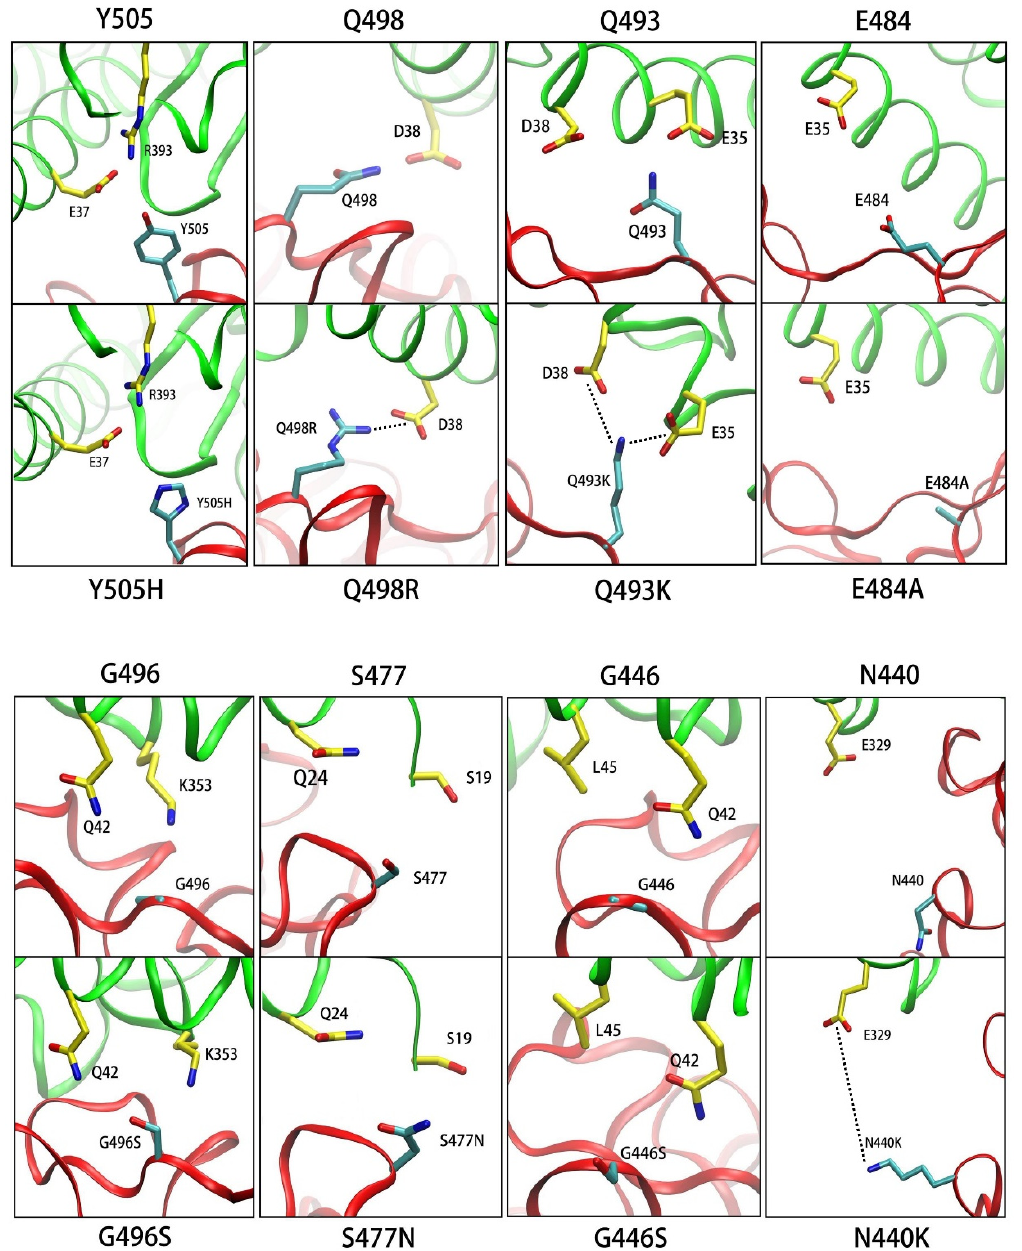
Figure 6. The local interaction structures of the wild type (above figures) and mutants (below figures) in SARS-CoV-2 S-protein/ACE2 complexes. The wild-type Y505 and mutated Y505H. The wild-type Q498 and mutated Q498R. The wild-type Q493 and mutated Q493K. The wild-type E484 and mutated E484A. The wild-type G496 and mutated G496S. The wild-type S477 and mutated S477N. The wild-type G446 and mutated G446S. The wild-type N440 and mutated N440K.